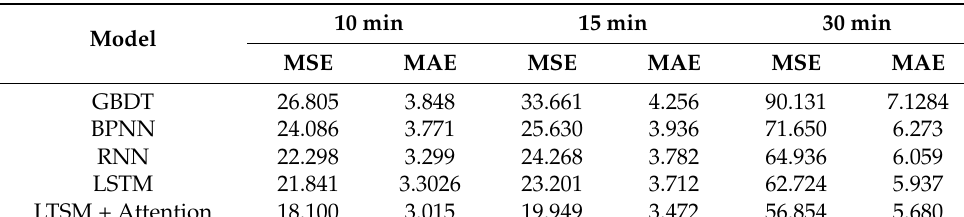
Table 3. Error comparison of different models.